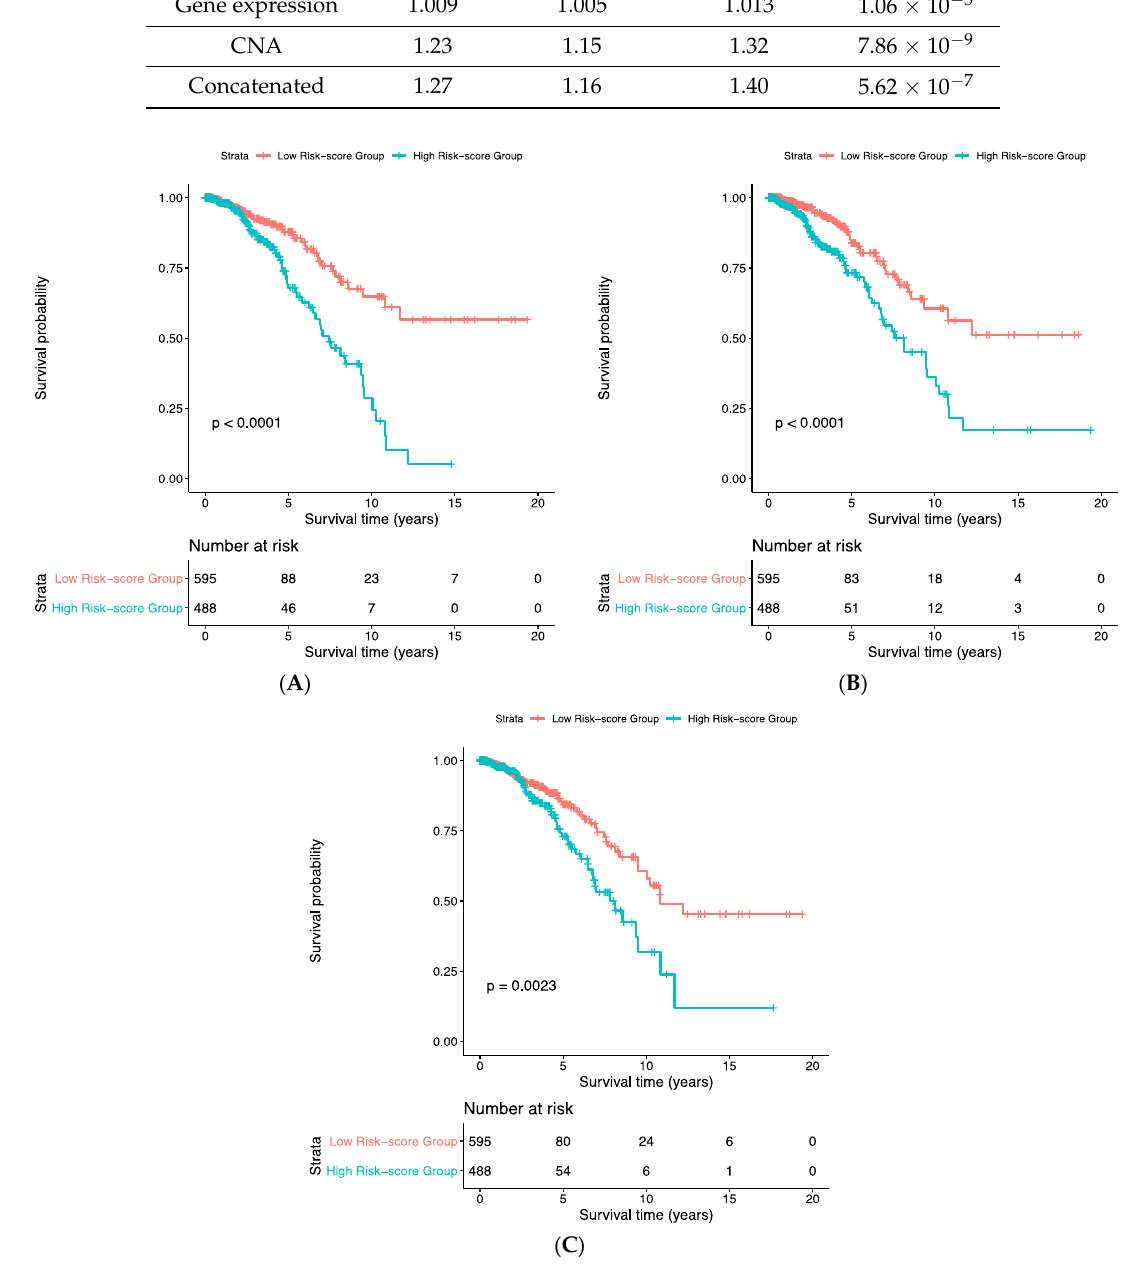
Figure 6. The KM-plots for risk scores based on the deep feature sets. ( A ) Gene expression data; ( B ) copy number alteration data; ( C ) the concatenated data.